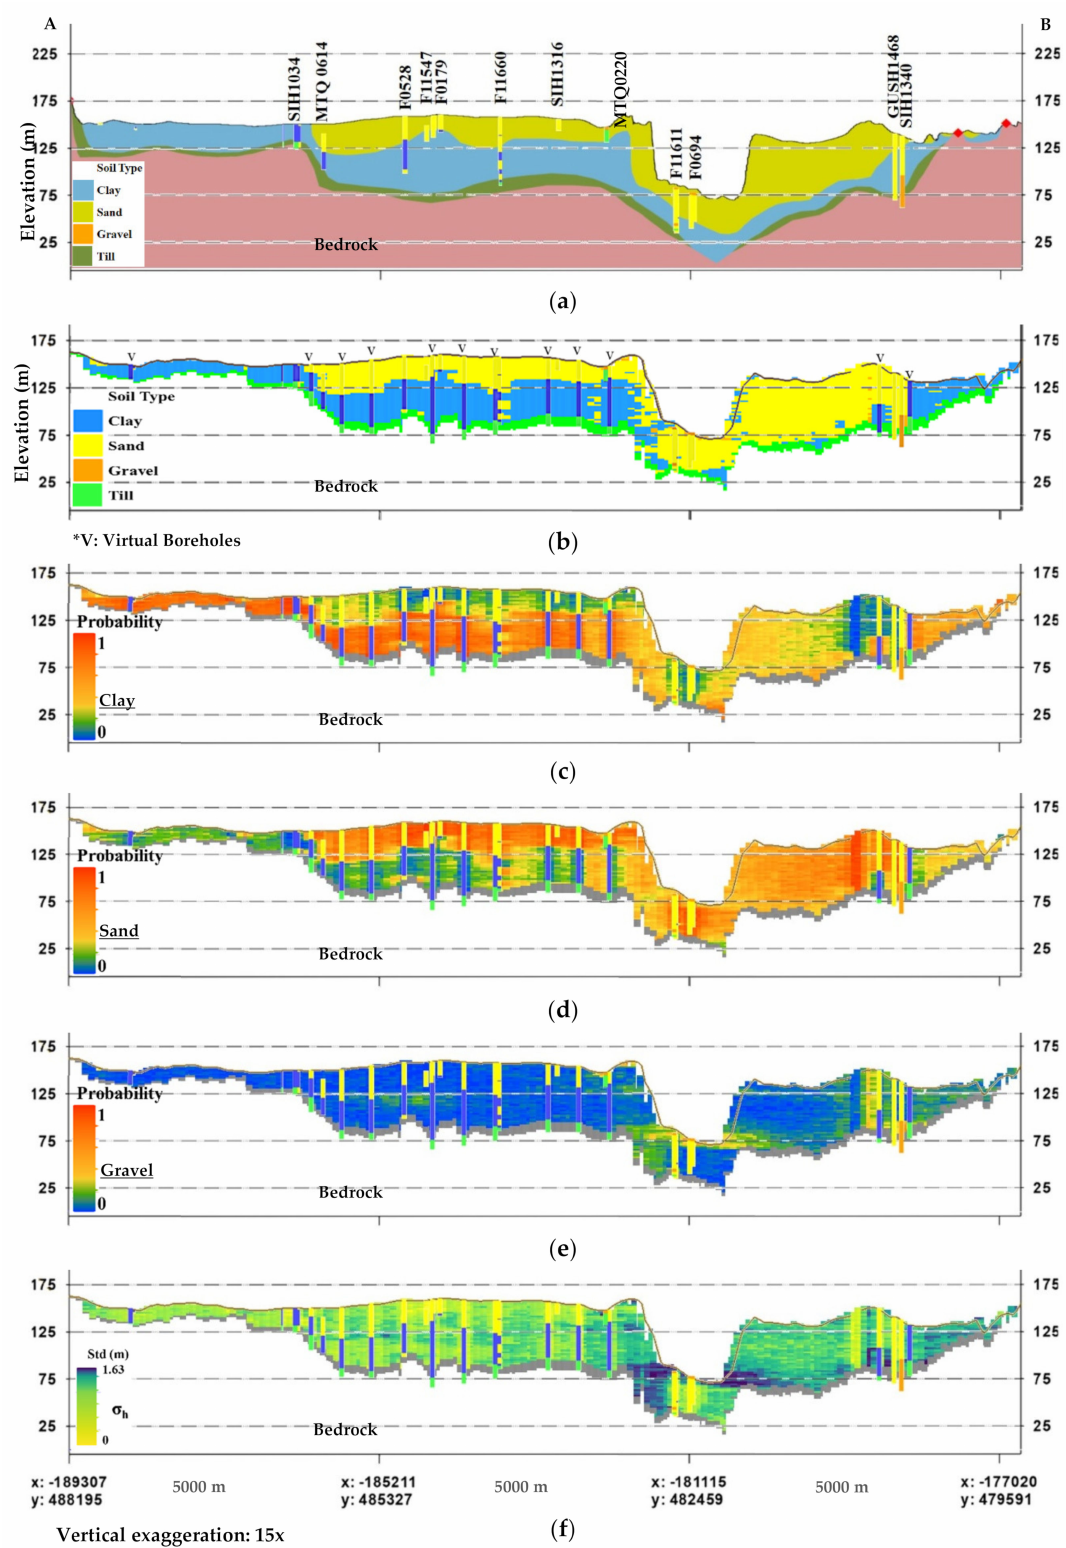
Figure 13. Stratigraphic cross-sections: ( a ) deterministic based on expert opinion (modified from CERM-PACES [34]); ( b ) soil units with the highest probability of occurrence based on conditional SIS; individual probabilities of occurrence for ( c ) clay, ( d ) sand and ( e ) gravel obtained from a set of 100 conditional SIS; and ( f ) total standard deviation ( σ h ) of the thickness computed by using the probability of categorical